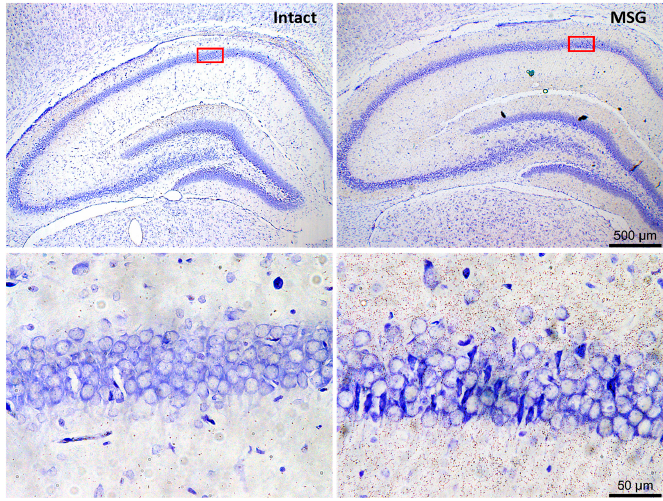
Figure 2. Representative images of neuronal excitotoxic damage in rat hippocampus after subcutaneous monosodium glutamate neonatally administered. Photomicrographs were taken at the level of the dorsal hippocampus, with a focus on the CA1 area (square red). Nissl stain. Scale bars correspond to 500 and 50 µm in upper and lower panels, respectively (for methodological details see: Rivera-Cervantes [131]).